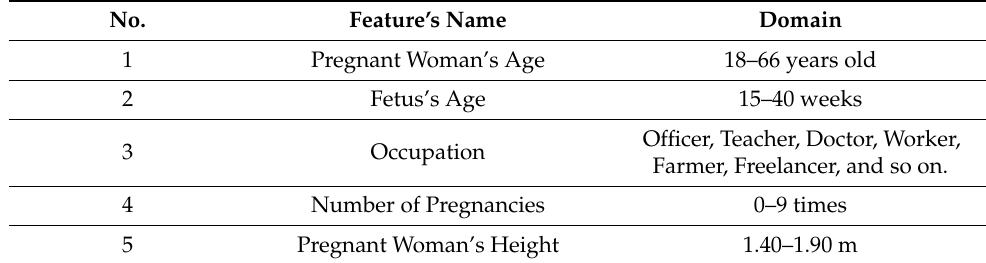
Table 6. List of features in the preeclampsia